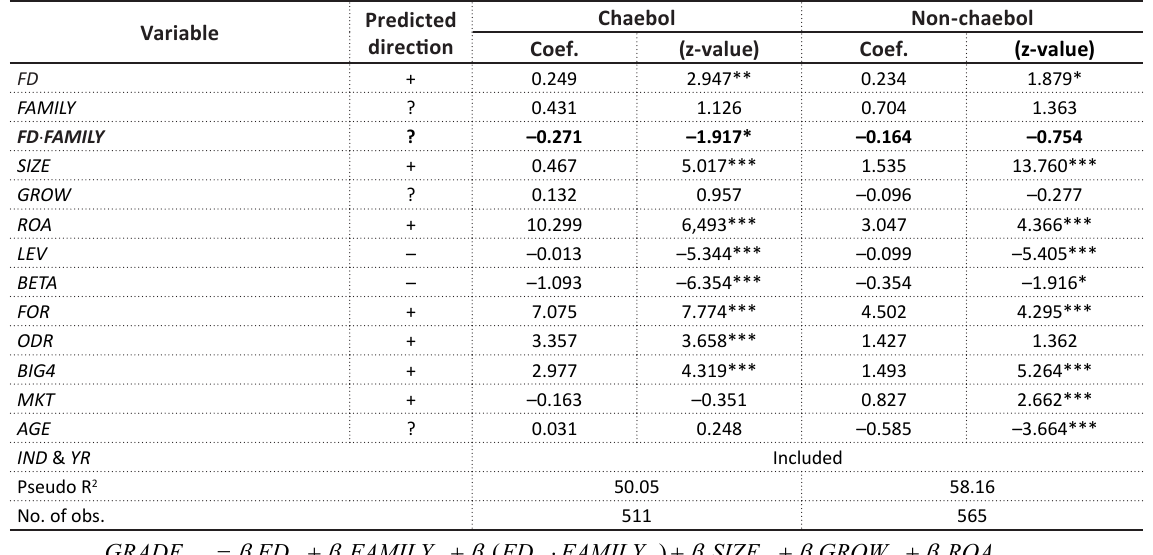
Table 6. The moderating effects of family relationships on the relationship between female directors and credit ratings (chaebol vs.